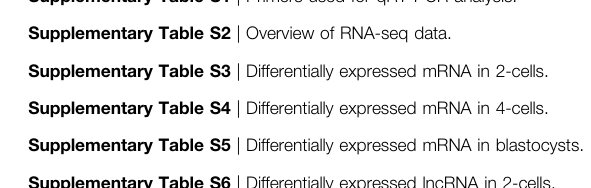
Supplementary Table S1 | Primers used for qRT-PCR analysis. Supplementary Table S2 | Overview of RNA-seq data. Supplementary Table S3 | Differentially expressed mRNA in 2-cells. Supplementary Table S4 | Differentially expressed mRNA in 4-cells. Supplementary Table S5 | Differentially expressed mRNA in blastocysts. Supplementary Table S6 | Differentially expressed lncRNA in